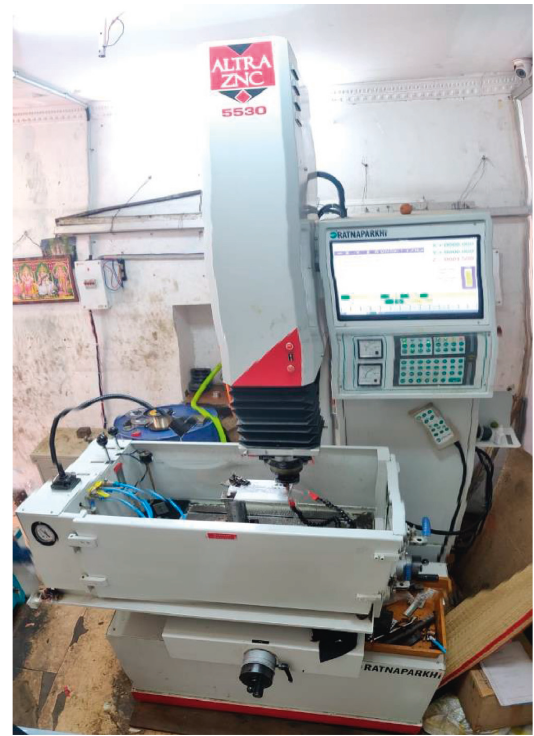
Figure 1: Electrical discharge machine used for this